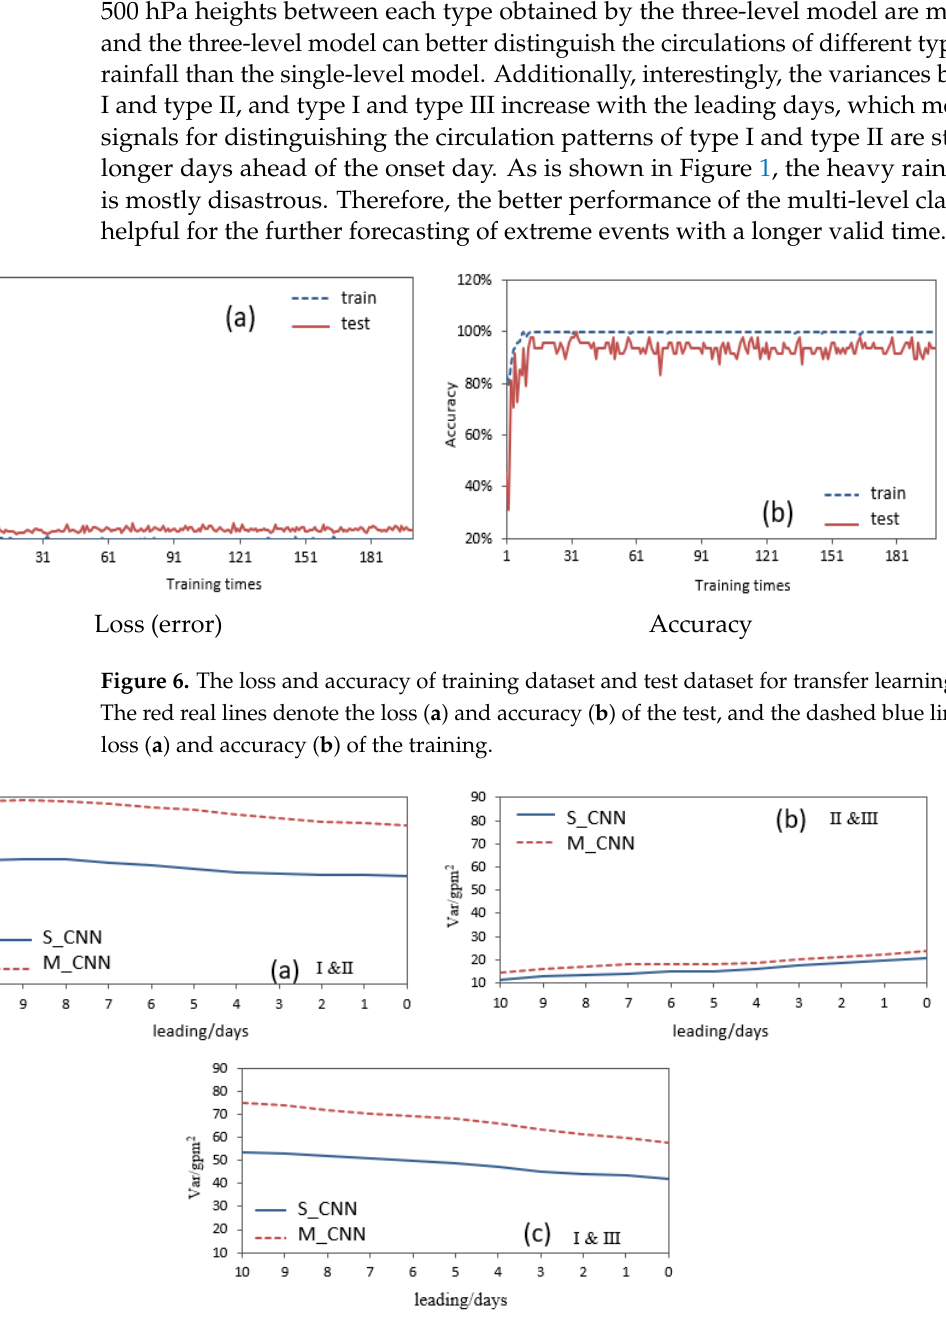
Figure 7. The variance between the 500 hPa height fields of different rainfall types by the CNN model with single-level (S_CNN) and three-level (M_CNN) circulation data (unit: gpm 2 ). ( a ) Patterns I and II; ( b ) Patterns II and III; ( c ) Patterns I and III.